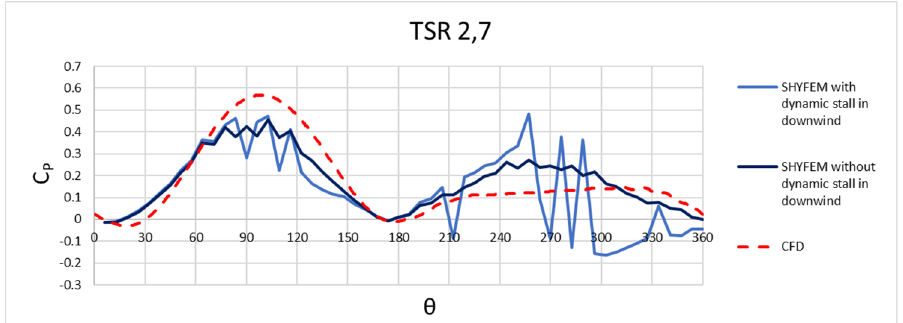
Figure 10. C P comparison between pure CFD and SHYFEM hybrid model with and without dynamic stall model in downwind.